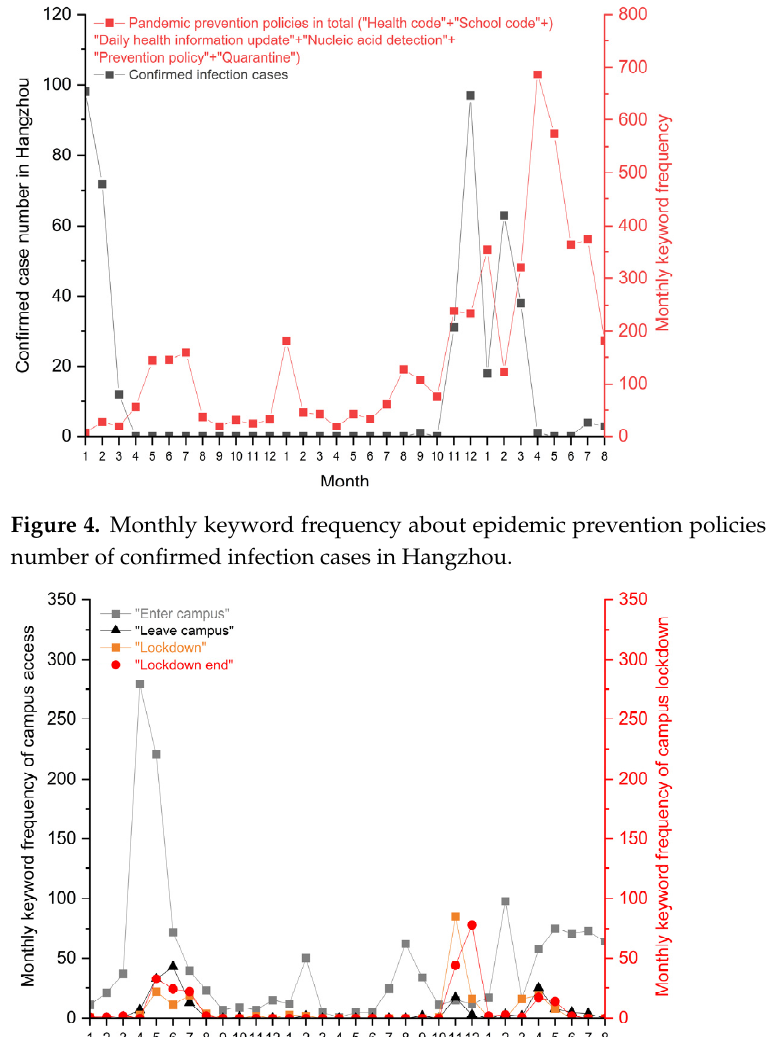
Figure 4. Monthly keyword frequency about epidemic prevention policies as compared with the number of confirmed infection cases in Hangzhou.